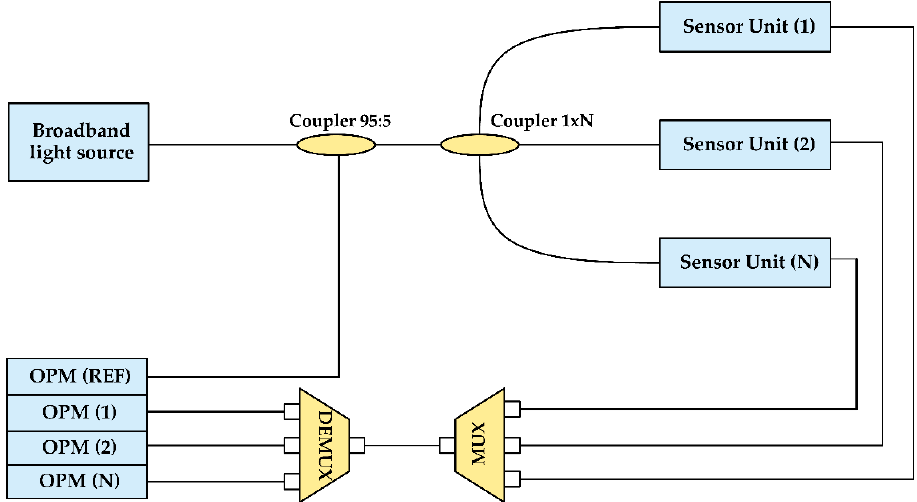
Figure 1. The proposed sensor network based on DWDM (Dense Wavelength Division Multiplexer) PM-PCF (Polarization-Maintaining Photonic Crystal Fiber) Sagnac loops.